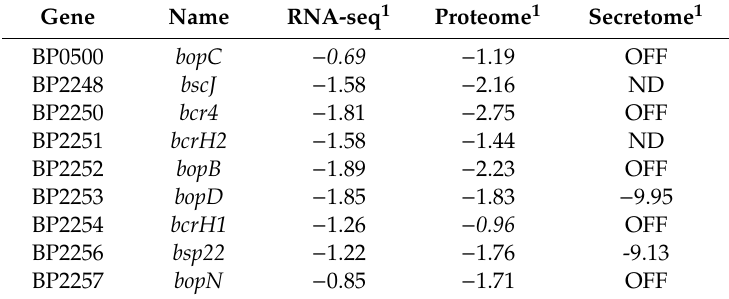
∆ hfq / wt comparison are shown for RNA-seq and proteomic analyses. Values that did not pass the statistical significance are shown in italics. ND: not determined in both strains in the respective analysis. OFF: protein was not detected in the ∆ hfq strain within the corresponding fraction.